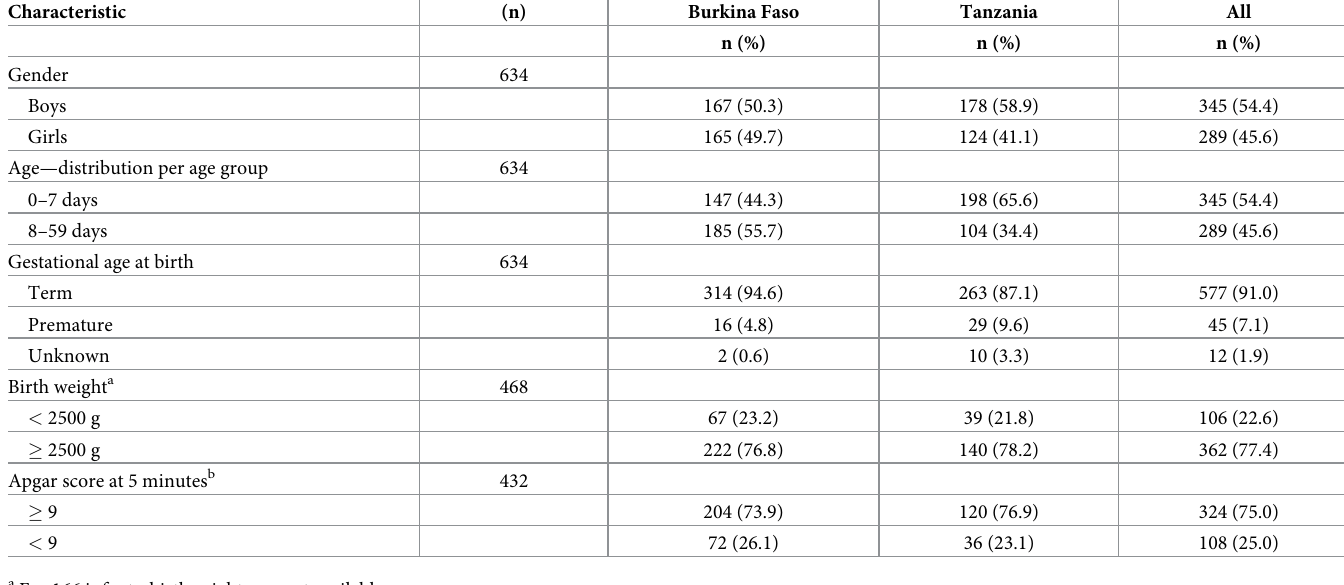
Table 1. Demographics characteristics of young infants with clinically suspected invasive